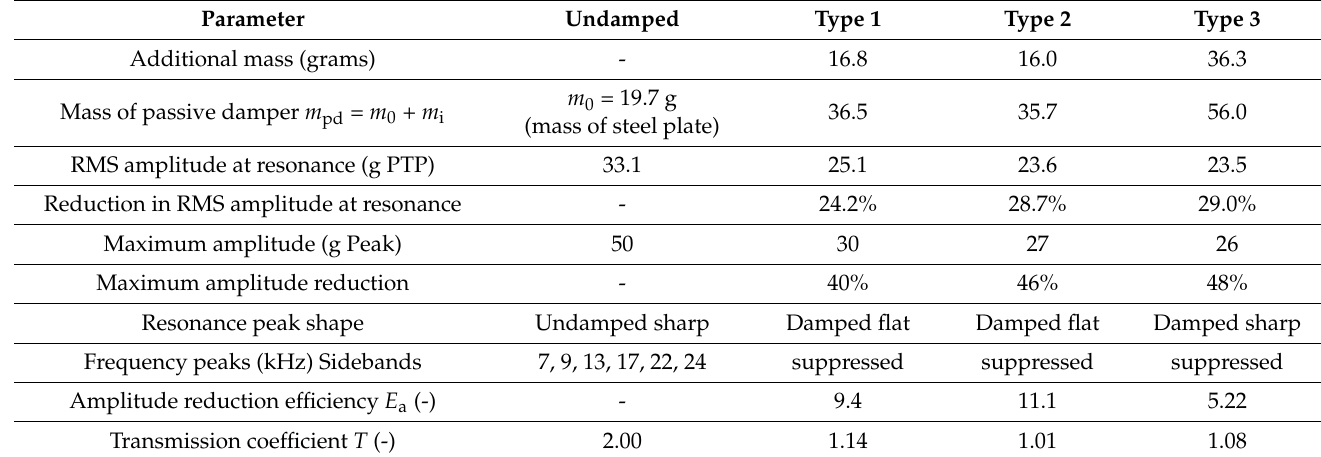
Table 3. Summary of